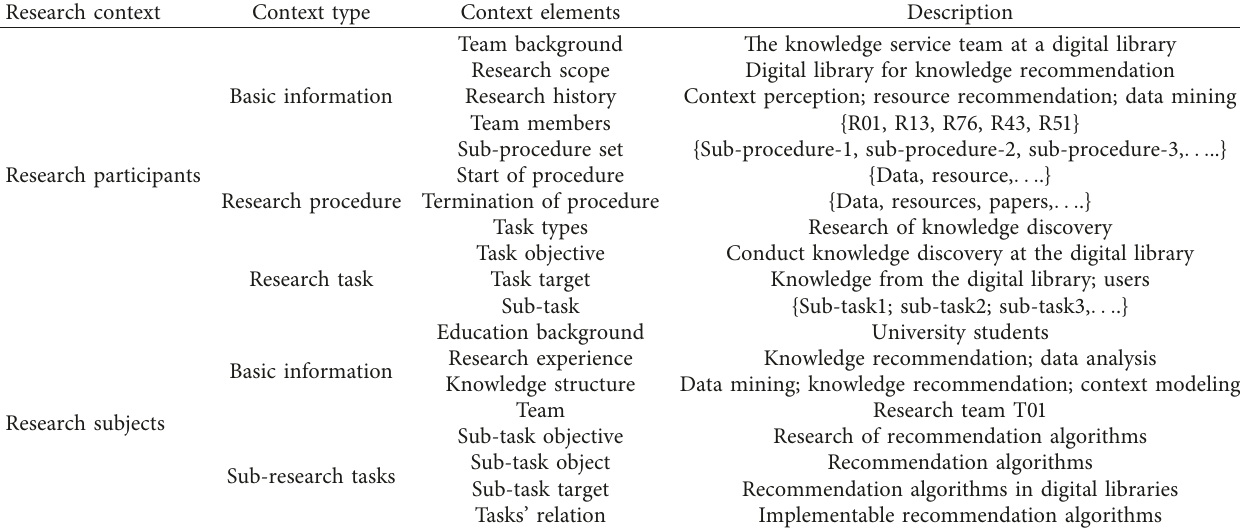
Table 1: Researchers’ R01 and its situational context.